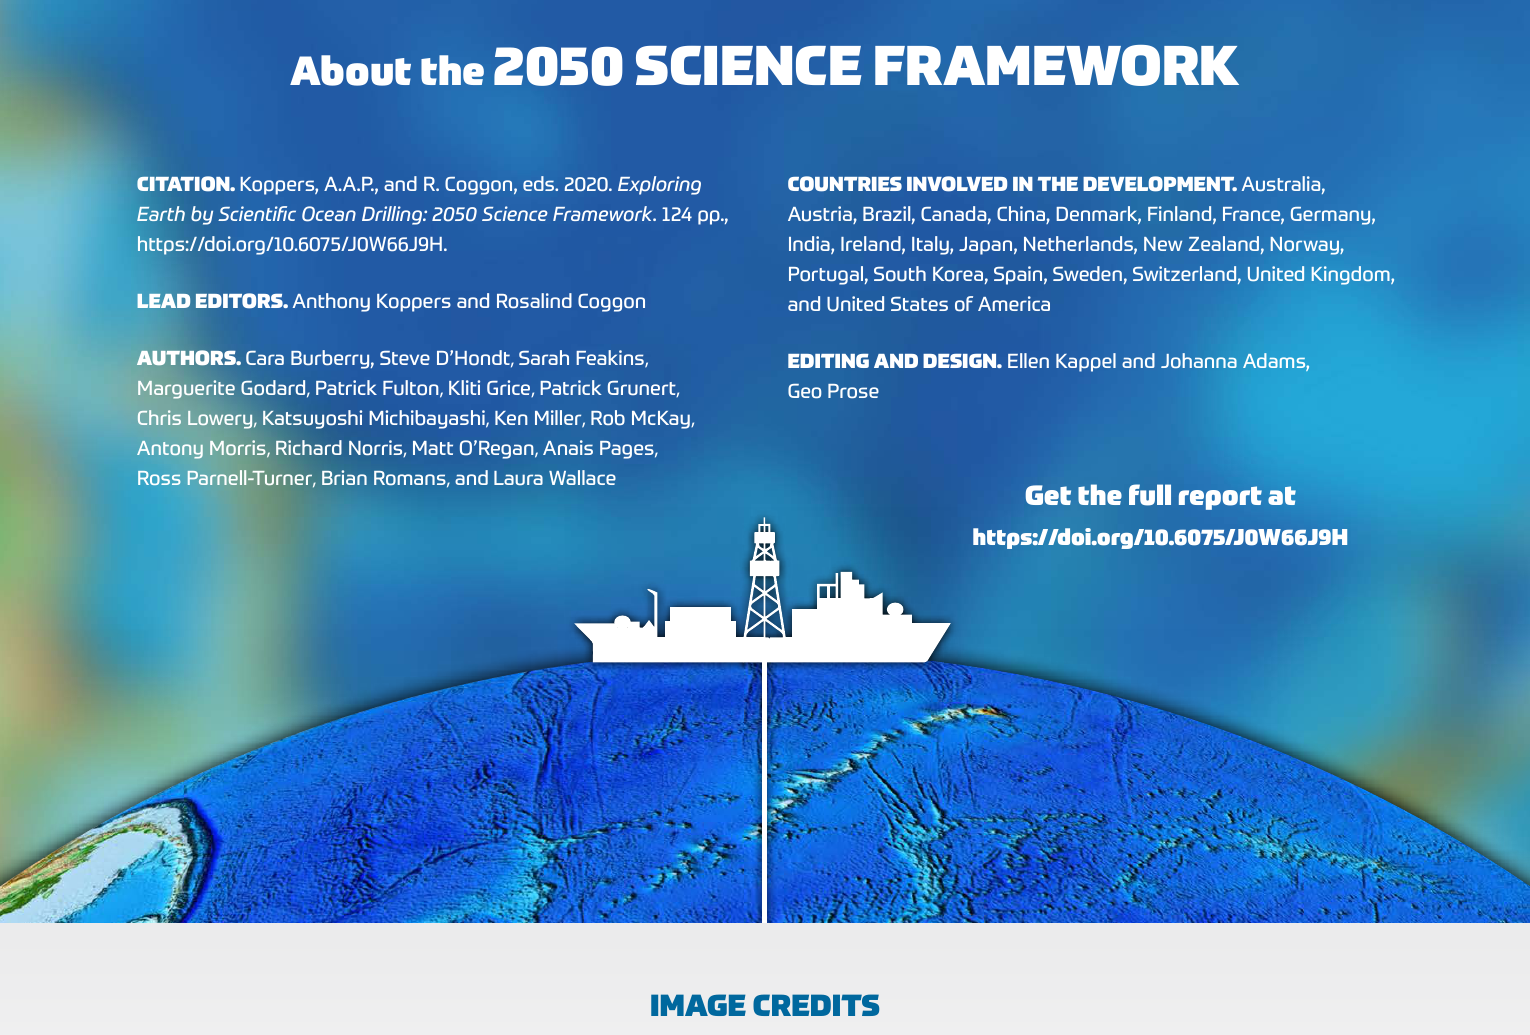
IMAGE CREDITS PAGE 3. (top right) Forest fire at night. Credit iStock.com/Byronsdad. (bottom left) Drone view of flooded neighborhood. Credit iStock.com/ RoschetzkyIstockPhoto. PAGE 4. Illustration by Antony Morris and Geo Prose. 9.0 PAGE 5. (top left) Tsunami devastation in Japan after the 2011 M w Tōhoku-oki earthquake. Credit: iStock.com/enase. (bottom right) Damage 8.8 earthquake in Chile. Credit: Simon Haberle, Australian from the 2010 M w National University. PAGE 6. (top right) Heart Reef aerial shot taken near Whitsunday islands, Queensland. Credit: iStock.com/byrneck. (bottom left) Tropical coral reef off of Nakinyo Island, Myanmar. Credit: iStock.com/Waranya Sawasdee. PAGE 7. Illustration by Geo Prose, inspired by Figure 4 in D’Hondt et al. (2019), https://doi.org/10.5670/oceanog.2019.146. Photo credits: (left) Deep sediments. From Figure 2 in Inagaki et al. (2015), https://doi.org/ 10.1126/science.aaa6882. (middle) Young oceanic crust. From Figure 3 in Ramirez et al. (2019), https://doi.org/10.3389/fmicb.2019.01983. (right) Old oceanic crust. Courtesy of Jason Sylvan, Texas A&M University. PAGES 8/9. (left) The IODP Bremen Core Repository at MARUM. Image credit: MARUM − Zentrum für Marine Umweltwissenschaften; Universität Bremen; V. Diekamp. (middle) Copper River Delta glacier runoff flows into the coastal waters of the Gulf of Alaska. NASA Earth Observatory image by Robert Simmon and Jesse Allen, using Landsat 8 data from the USGS Earth Explorer. (right) ECORD Summer School 2016 in Bremen, Germany. The goal of the summer schools is to train the next generation of scien- tists. Credit: V. Diekamp, MARUM &